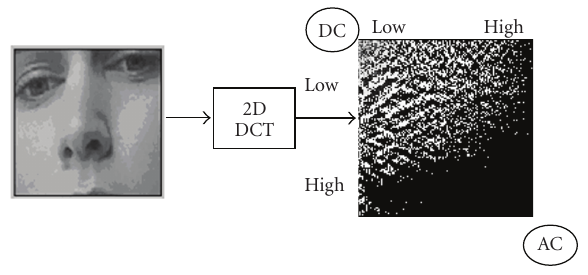
Figure 2: The ROI image transformation with full-size DCT.